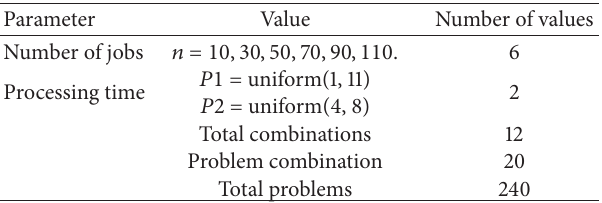
Table 3: ACI values for the problem.